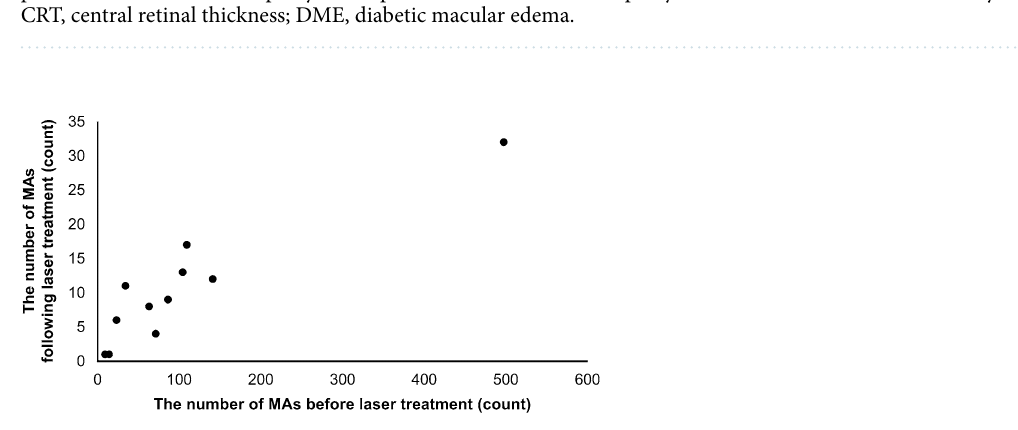
Table 1. Baseline characteristics of patients. Values are presented as means ± standard deviations. NPDR, non- proliferative diabetic retinopathy; PDR, proliferative diabetic retinopathy; BCVA, best corrected visual acuity; CRT, central retinal thickness; DME, diabetic macular edema.